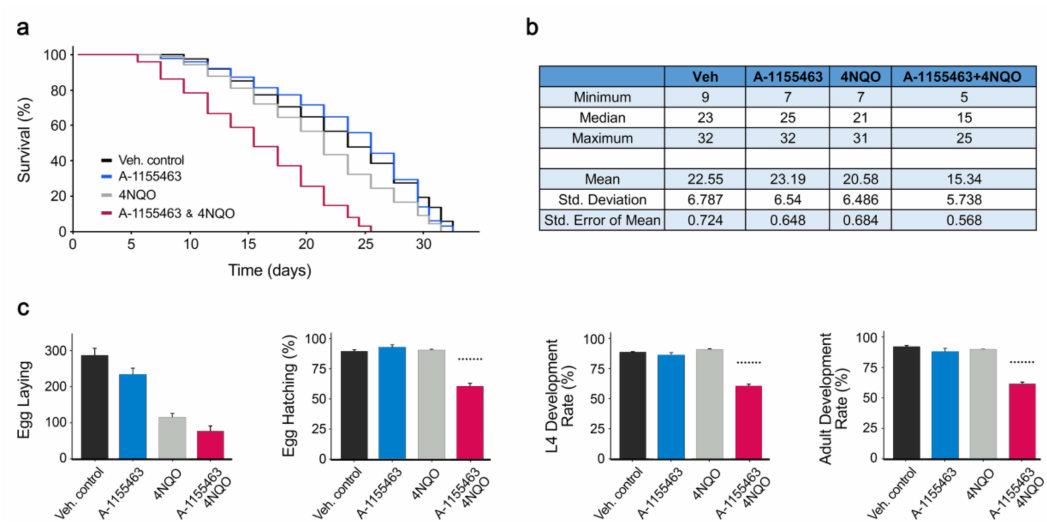
Figure 2. A combination of Bcl-xL- specific inhibitor A-1155463 and DNA-damaging agent 4NQO exhibits synergistic toxicity on lifespan, reproduction and development to the wild type roundworm C. elegans . ( a ) Kaplan-Meier survival curves and estimates of survival data ( b ) of worms challenged with 10 µ M A-1155463, 10 µ M 4NQO, drug combination or vehicle. The log-rank Mantel-Cox test was used for statistical analysis. ( c ) Toxicity detection for the di ff erent stages of C. elegans reproduction and development after the treatment with 10 µ M A-1155463, 10 µ M 4NQO or their combination (Mean ± SD). Dotted lines above combination bars represent the expected e ff ect given by Bliss reference model. *******—expected e ff ect of drug